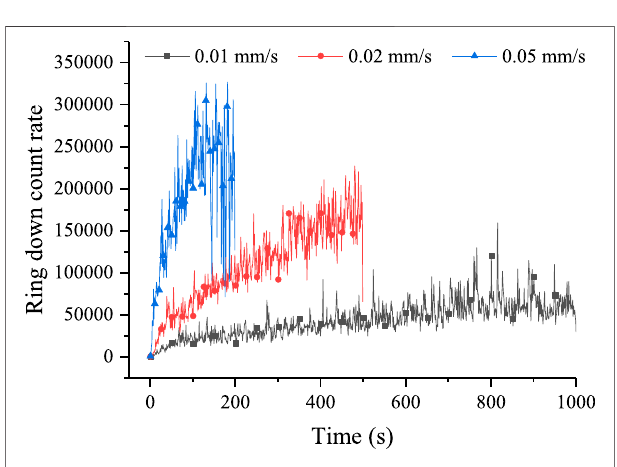
FIGURE 8 | Variation curve of fl exural guided wave ring down count rate with different deformation rate.